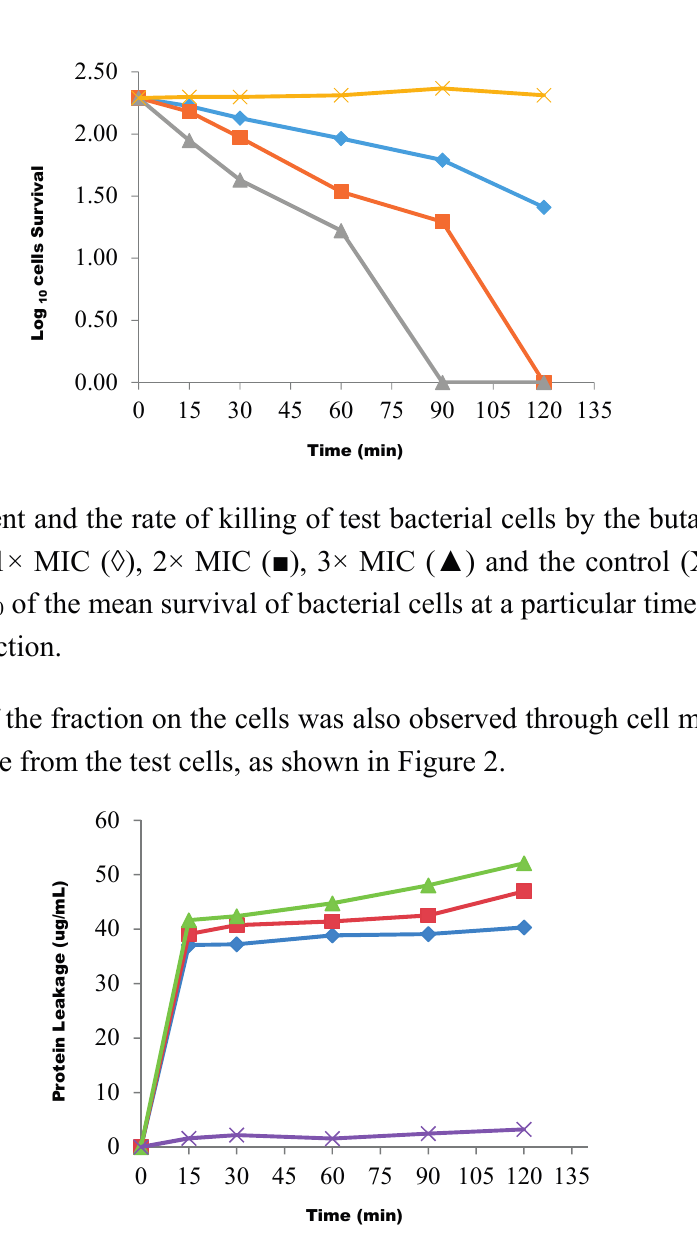
Figure 2. The effect of the butanol fraction on protein leakage from test cells at concentrations of 1× MIC ( ◊ ), 2× MIC ( ■ ), 3× MIC ( ▲ ) and control (X). Each point represents the amount of protein leaked (µg/mL) from the cells at a particular time interval in the presence of the